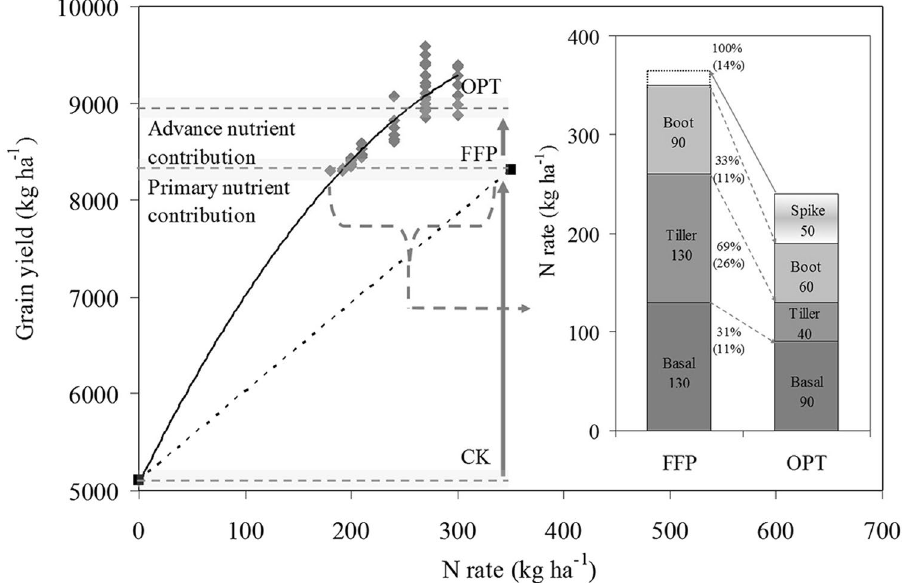
Figure 4. Response curves of rice grain yield to N rate and the nutrient contribution stage; further details are in Sui et al . 8 . The result of improving rice grain yield and nitrogen use efficiency depended on the optimized N managements (OPT, insert figure) at different rice growth stages. The insert figure shows rice N management strategies between OPT and farmers’ fertilizer practices (FFP). The percentage and the dotted and solid arrows represent the N rate ratios of reduced or increased between OPT and FFP for the different and total growth stages in and out of parentheses,